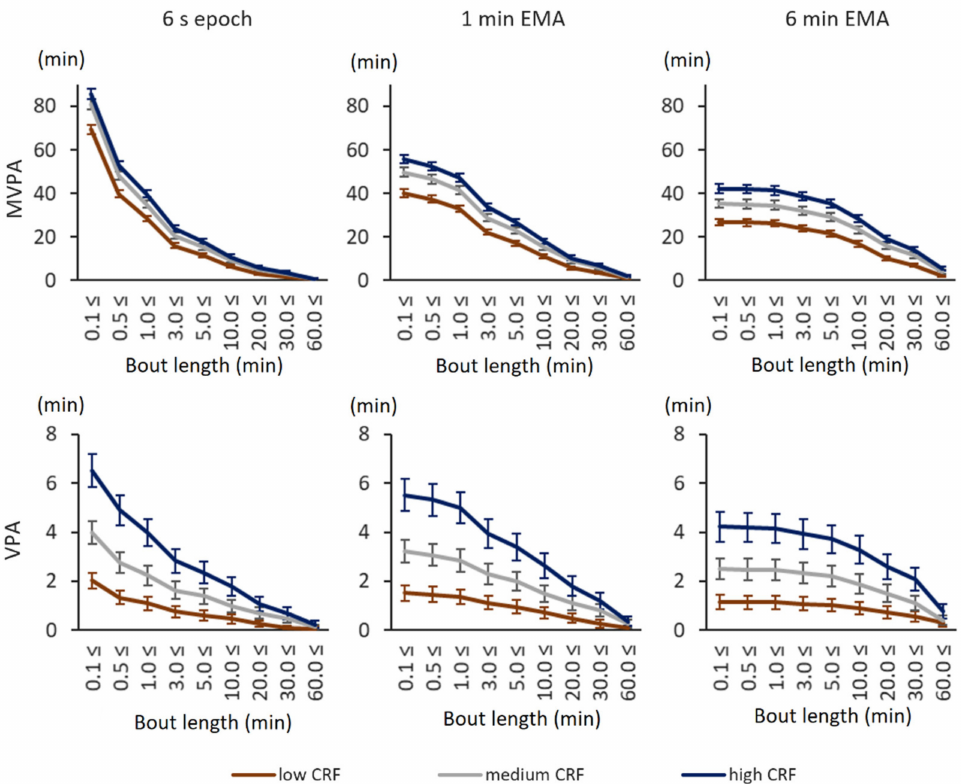
Figure 1. Daily moderate-to-vigorous physical activity (MVPA) and vigorous physical activity (VPA) time accumulation with absolute intensity thresholds. The x -axis shows the minimum accepted bout length in minutes, and the y -axis shows the accumulated time in minutes. The error bars denote 95% confidence intervals. The upper graphs show the accumulated MVPA time (over 3.0 metabolic equivalent (MET)), and the lower graphs show the VPA time (over 6.0 MET). The left-most graphs show the accumulated time from 6 s epoch, the middle graphs show that from 1 min exponential moving average (EMA), and the right-most graphs show that from 6 min